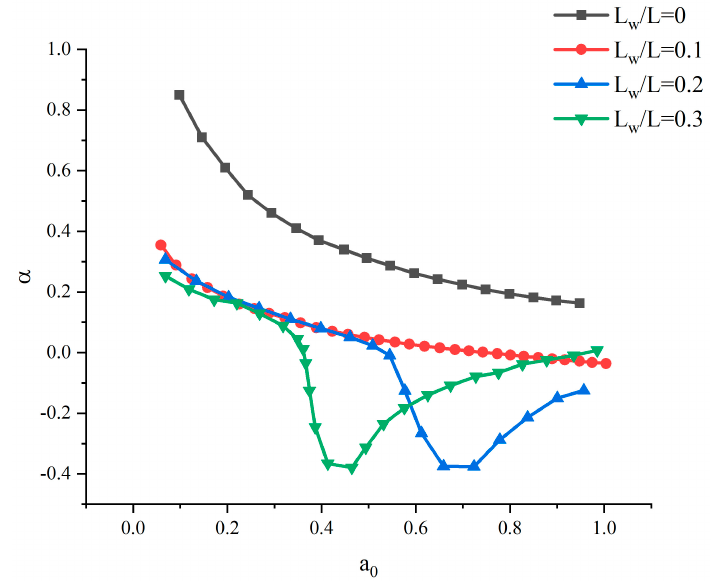
Figure 13. Pile–pile interaction under different pile embedded ratios. The influence of different incidences angle θ is studied, i.e., 0 , 45 , and 90 , respectively. As shown in Figure 14, when θ = 0 , the curve fluctuates significantly, the minimum value of α is the smallest among three angles, and the maximum value of α is the largest among three angles. When θ = 90 , the value of α is slightly smaller than that of θ = 0 . When θ = 45 ◦ , the change of α is moderate, and no significant fluctuation is observed.